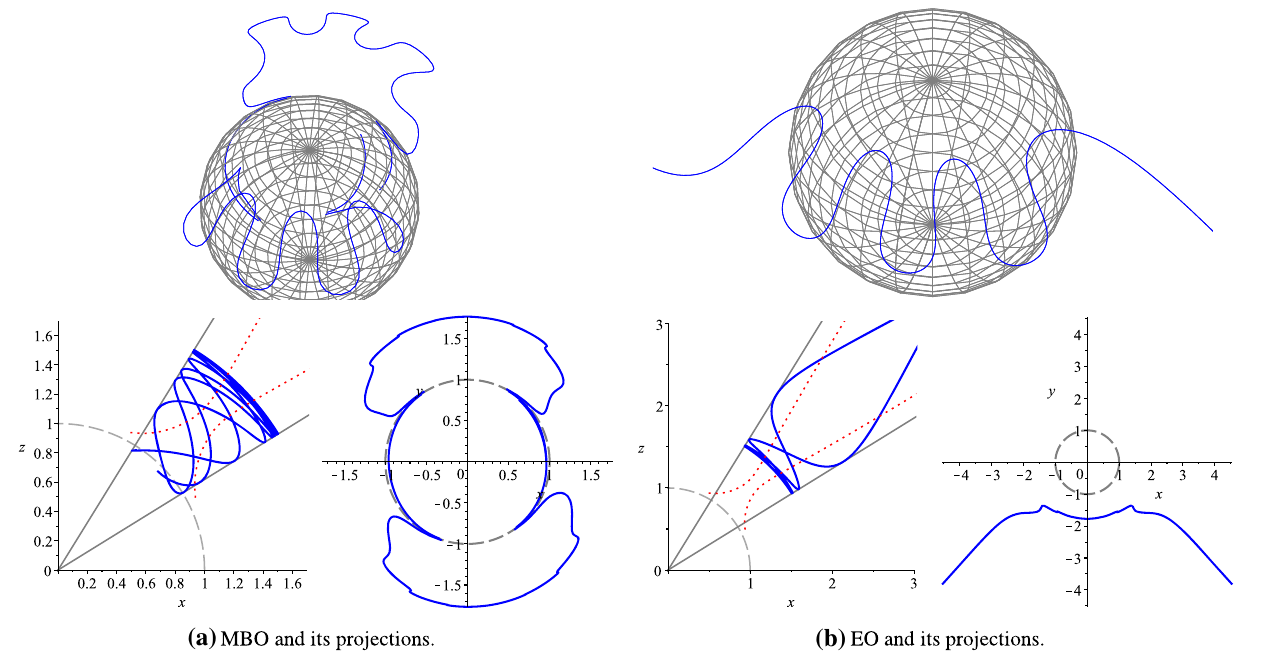
Fig. 7 MBO and EO for parameters K = 4 , L = 4 , δ = 0 , l = 1 , J = 0, and energy E = 0 . 386699. The projections onto the x - z plane (bottom left) show the turning points of the φ motion as a dotted